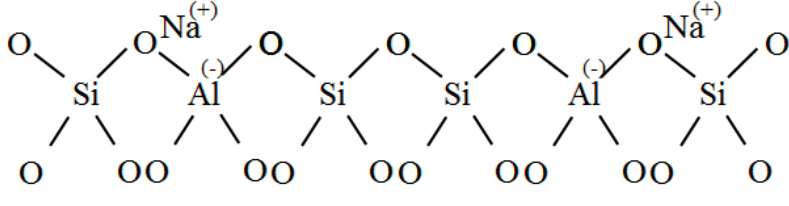
Figure 1. Tetrahedral framework structure.